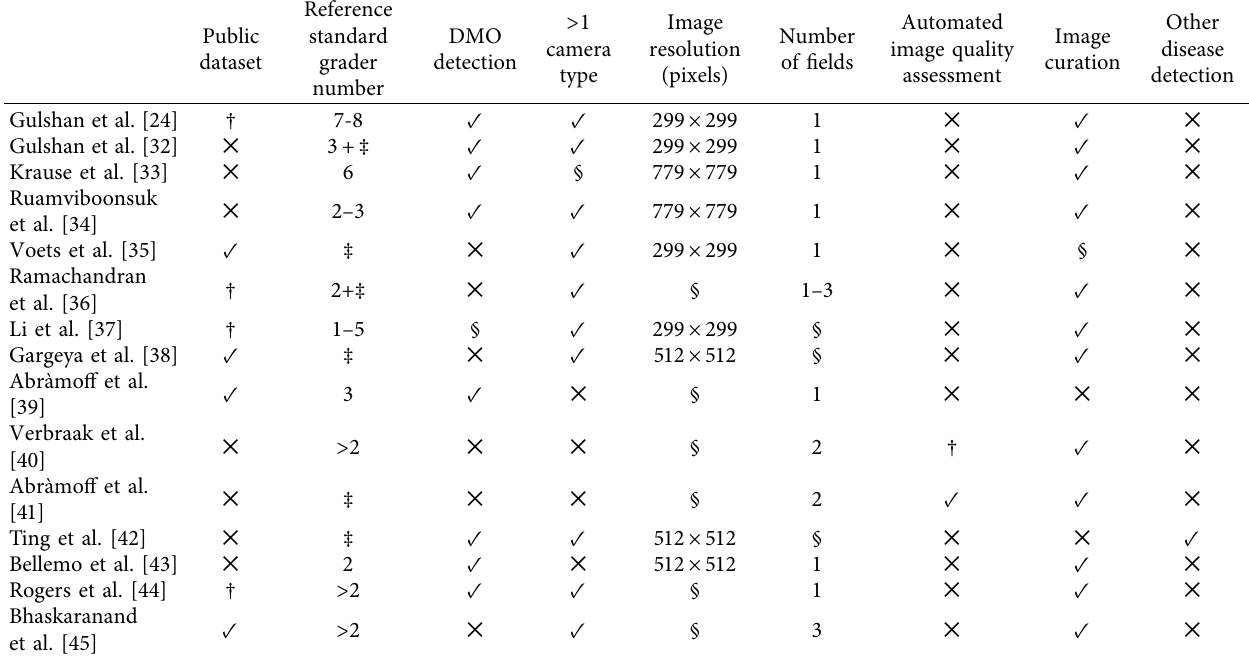
Table 2: Potential sources of algorithm limitations present in the validation datasets of the 13+2 included studies. ✓ � yes; ✕ � no; † � combination; ‡ � exact number unspecified; § �